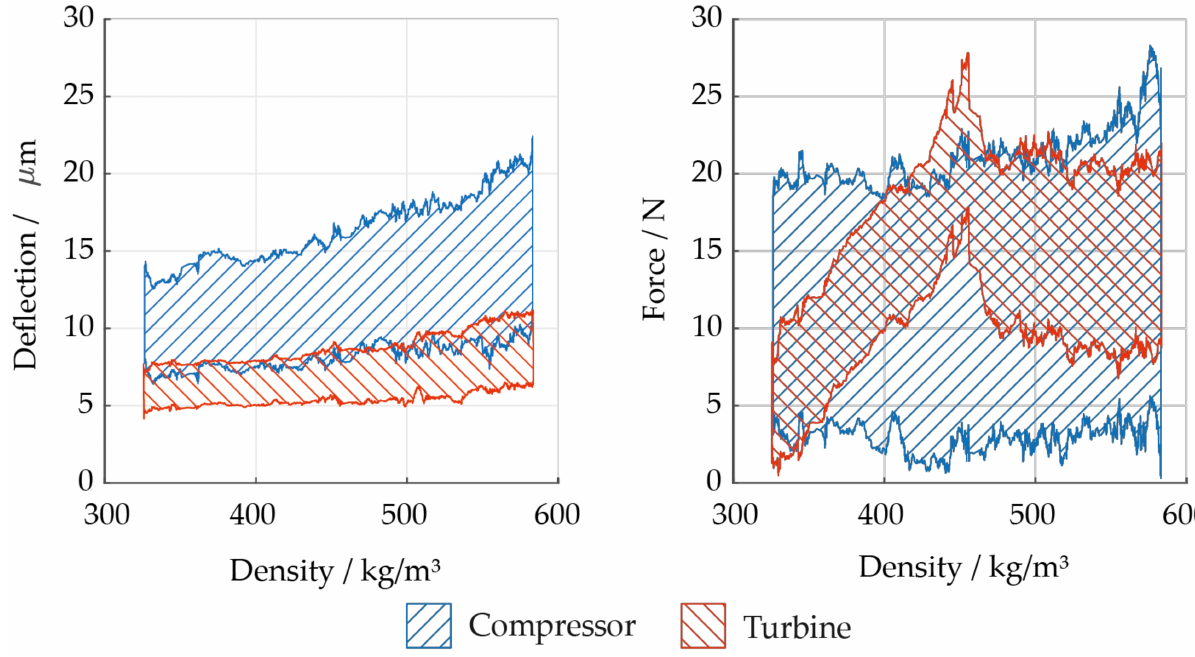
Figure 11. Deflection of the rotor and radial force of the bearings on turbine and compressor side over compressor inlet density at constant rotational speed of 25,000 rpm: ( left ) deflection; ( right ) radial